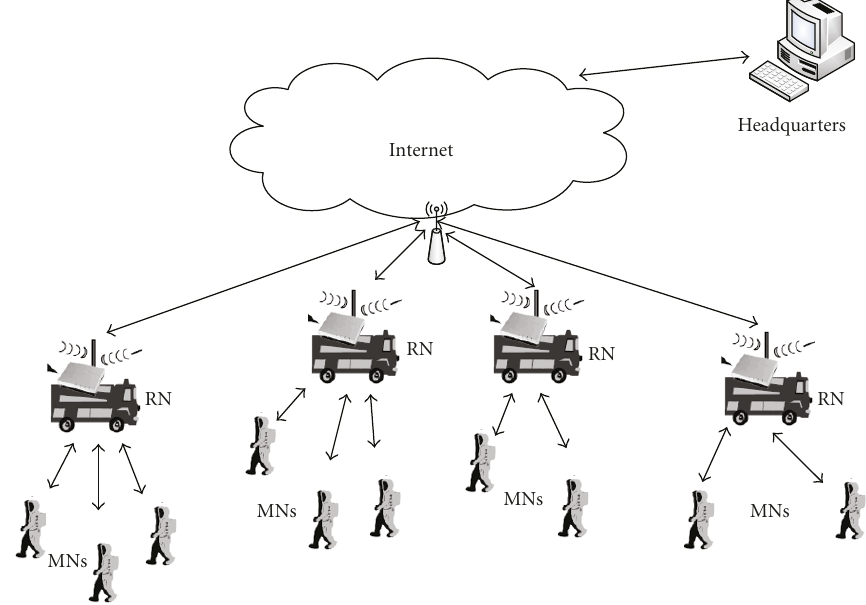
Figure 1: A realistic scenario of